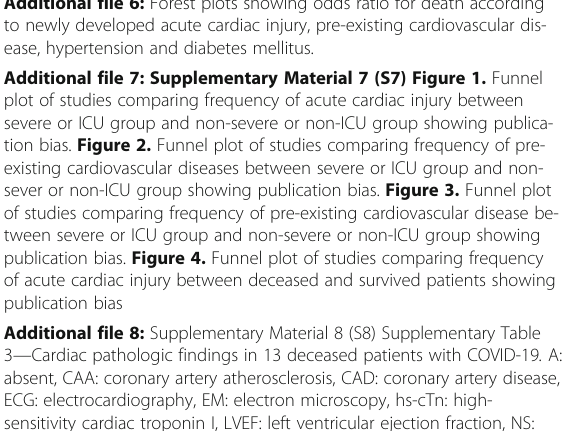
lysis of pre-existing diabetes. Figure 10. Forest plot of the pooled fre- quency analysis of patients with elevated NT-pro BNP levels. Figure 11. Forest plot of the pooled frequency analysis of patients with elevated car- diac troponins levels. Figure 12. Forest plot of the pooled frequency analysis of patients with elevated creatine kinase-MB levels. Figure 13. Forest plot of the pooled frequency analysis of patients with elevated cre- atine kinase levels. Figure 14. Forest plot of the pooled frequency ana- lysis of patients with elevated D-dimer levels. Figure 15. Forest plot of the pooled frequency analysis of patients with elevated lactate dehydro- genase levels. Figure 16. Forest plot of the pooled frequency analysis of patients with elevated interleukin- 6 levels. Figure 17. Forest plot of the pooled frequency analysis of patients with elevated C-Reactive Protein (CRP) levels. Figure 18. Forest plot of the pooled frequency analysis of patients with elevated erythrocyte sedimentation rate (ESR) levels. Figure 19. Forest plot of the pooled frequency analysis of patients with elevated ferritin